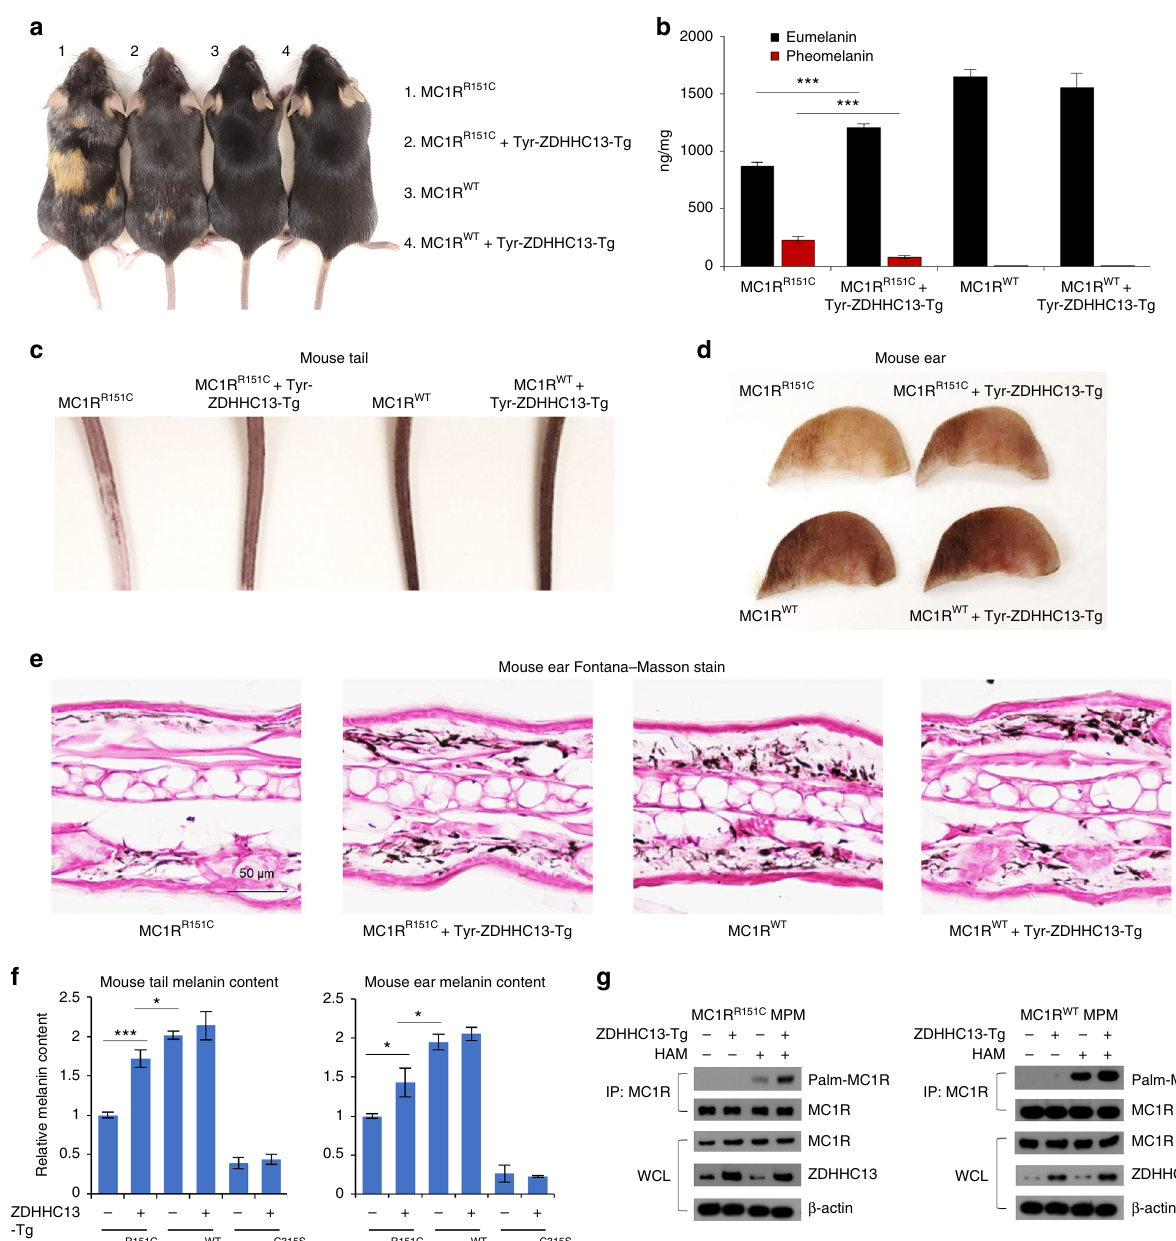
Fig. 2 Transgenic ZDHHC13 increases MC1R R151C signaling in vivo. a Images of mice with the indicated genotypes. All mice are on the C57/BL6J background. b Measurement of eumelanin and pheomelanin content in the whole back skin collected from the indicated mice shown in a . Eumelanin and pheomelanin were quanti fi ed by high-performance liquid chromatography based on the level of pyrrole-2,3,5-tricarboxylic acid (PTCA) by alkaline hydrogen peroxide oxidation of eumelanin and 4-amino-3-hydroxyphenylalanine (4-AHP) by hydriodic acid reductive hydrolysis of pheomelanin, respectively. Final results were determined by a conversion as described (eumelanin = 45 × PTCA, pheomelanin = 9 × 4-AHP). Three independent mice were used. c Tails and d ears of the indicated mice as shown in a . e Fontana – Masson staining of the indicated ear sections as shown in d . f Melanin quanti fi cation of the indicated tail and ear samples as shown in c , d . Three independent mice were used. g Melanocytes were isolated from the dorsolateral skin of 3.5-day postnatal mice. Total protein was extracted from mouse primary melanocytes and was then used for immunoprecipitation (IP) with speci fi c anti-melanocortin-1 receptor antibodies. Acyl biotin exchange reaction and immunoblot analysis using the indicated antibodies were performed subsequently. * p < 0.05, *** p < 0.001, unpaired Student ’ s t test. Error bars represent ± 19% (3/16) of mice with MC1R C315S , MC1R R151C , and MC1R WT , respectively (Fig. 3b). More importantly, our data indicated that and histologic features (Fig. 3c and Supplementary Fig. 2a). melanoma incidence was much lower and with delayed fi rst diagnosis (day 50 compared to day 39) in the Tg-ZDHHC13/ MC1R R151C mice than in the MC1R R151C mice (27% (4/15) vs. 64% (9/14), log-rank test, p = 0.0457; Fig. 3b). All melanomas